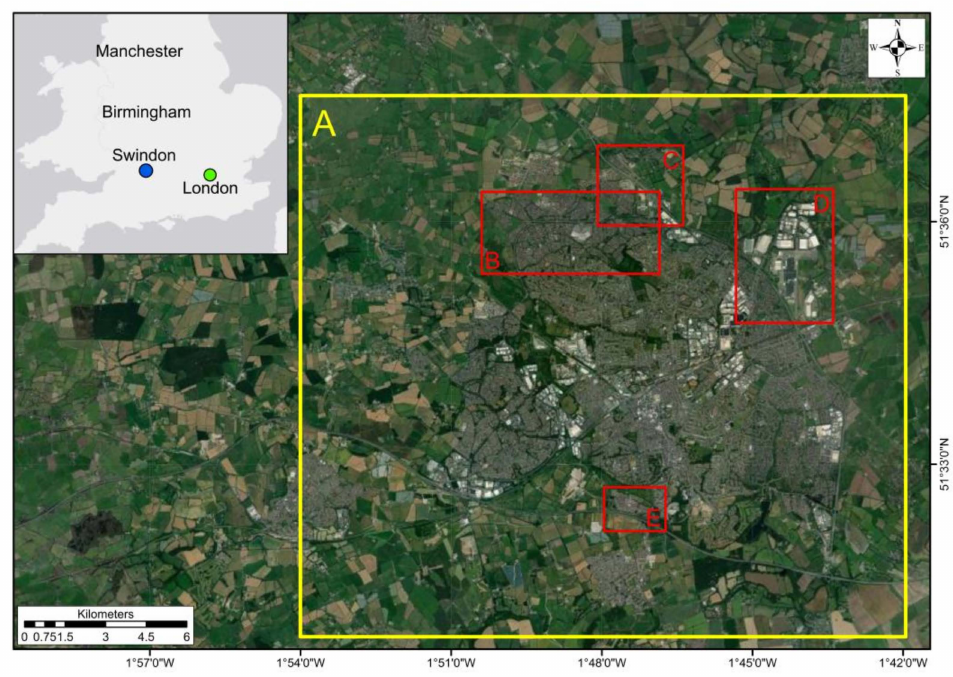
Figure 1. Location of Swindon in the UK relative to London. Yellow A: Study area. Red B: Haydon Wick, C: Blunsdon Bypass, D: South Marston industrial complex, E: East